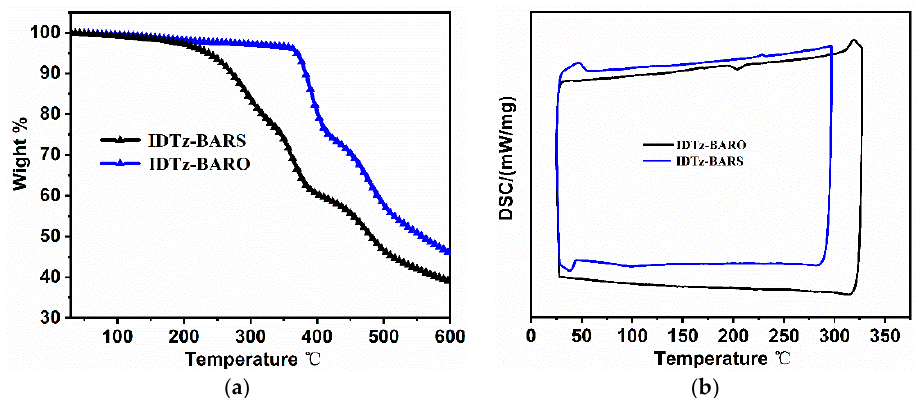
Figure 2. ( a ) Thermogravimetric analysis of acceptors IDTz-BARS and IDTz-BARO at a temperature ramp rate of 10 °C/min under N 2 . ( b ) DSC thermograms of IDTz-BARS and IDTz-BARO from the second heating and cooling scans at a temperature ramp rate of 10 °C/min under N 2 .